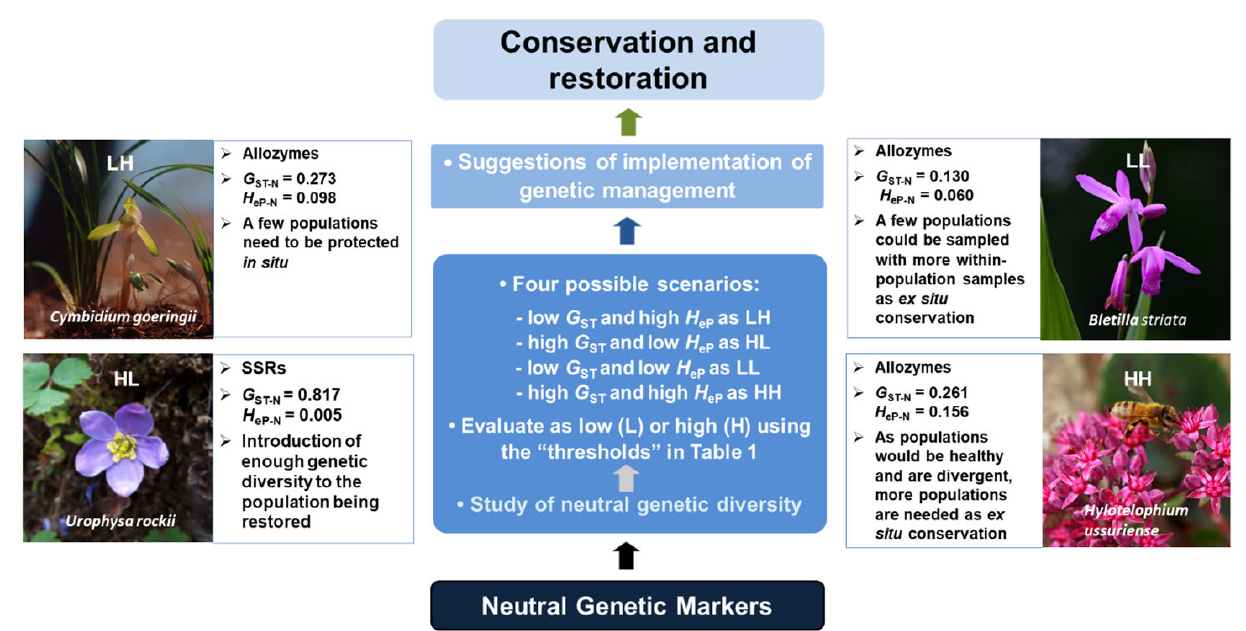
Figure 1. Flow chart on the applications of neutral genetic markers to conservation, restoration, and management strategies. We follow the four genetic scenarios according to levels and degree of neutral genetic diversity (i.e., LH or low G ST-N (L) and high H e (H), HL or high G ST-N and low H e , LL or low G ST-N and low H e , and HH or high G ST-N and high H e , where “L” and “H” stand for “low” and “high”, respectively; Ottewell et al. (2016)). For details of conservation management strategies for each genetic scenario, refer to the text. Reference for LH is from Chung et al. [54], HL from Xie et al. [57], LL from Chung et al. [62], and HH from Chung et al. [63]. Photo of Urophysa rockii was taken from Xie et al. [64], which is under license CC BY 4.0 (https://creativecommons.org/licenses/by/4.0/ accessed on 21 September 2021)–no changes were made by